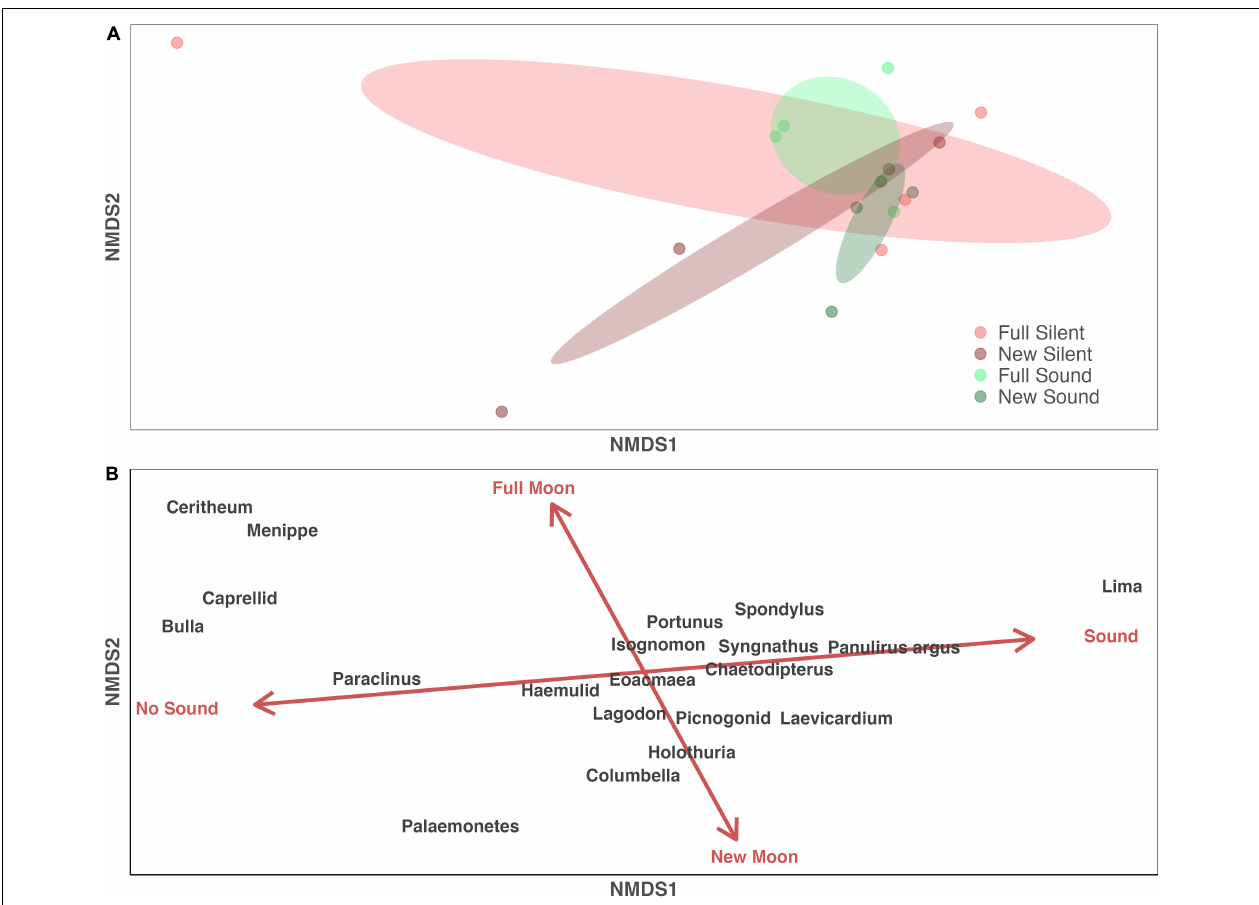
FIGURE 5 | Two-dimensional non-metric multidimensional scaling plot showing the relationships among the lunar and sound-playback treatment groups. Sound playback groups are shown in green, whereas no sound playback control groups are shown in red; darker color shades indicate new moon, and lighter color shades indicate full moon. Top panel (A) shows site groupings, and bottom panel (B) shows species locations in the ordination space with treatment vectors (in